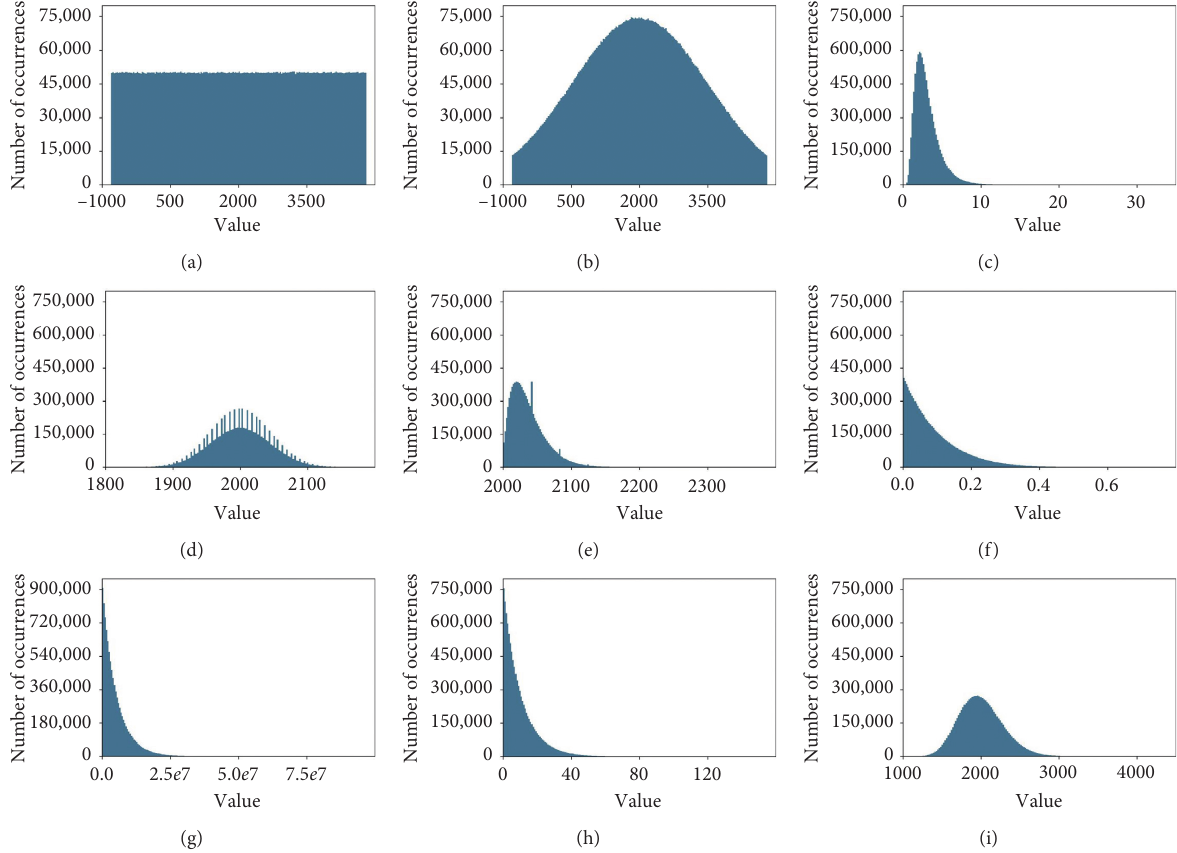
Figure 8: Examples of 9 distribution histograms of raw experimental datasets with the scale of 10 million: (a) a uniform distribution in the range of [ − 800, 4800], (b) a normal distribution with μ � 2000 , σ � 1500, (c) a log normal distribution with μ � 2000 , σ � 1500, (d) a Poisson distribution with λ � 2000, (e) a negative binomial distribution with r � 2 . 17 ,p � 0 . 055, (f) a beta distribution with α � 1 , β � 10, (g) an Table 1: Rates of violating monotonicity (RVM) and violating boundedness (RVB) of the four prediction methods. Prediction methods RVM